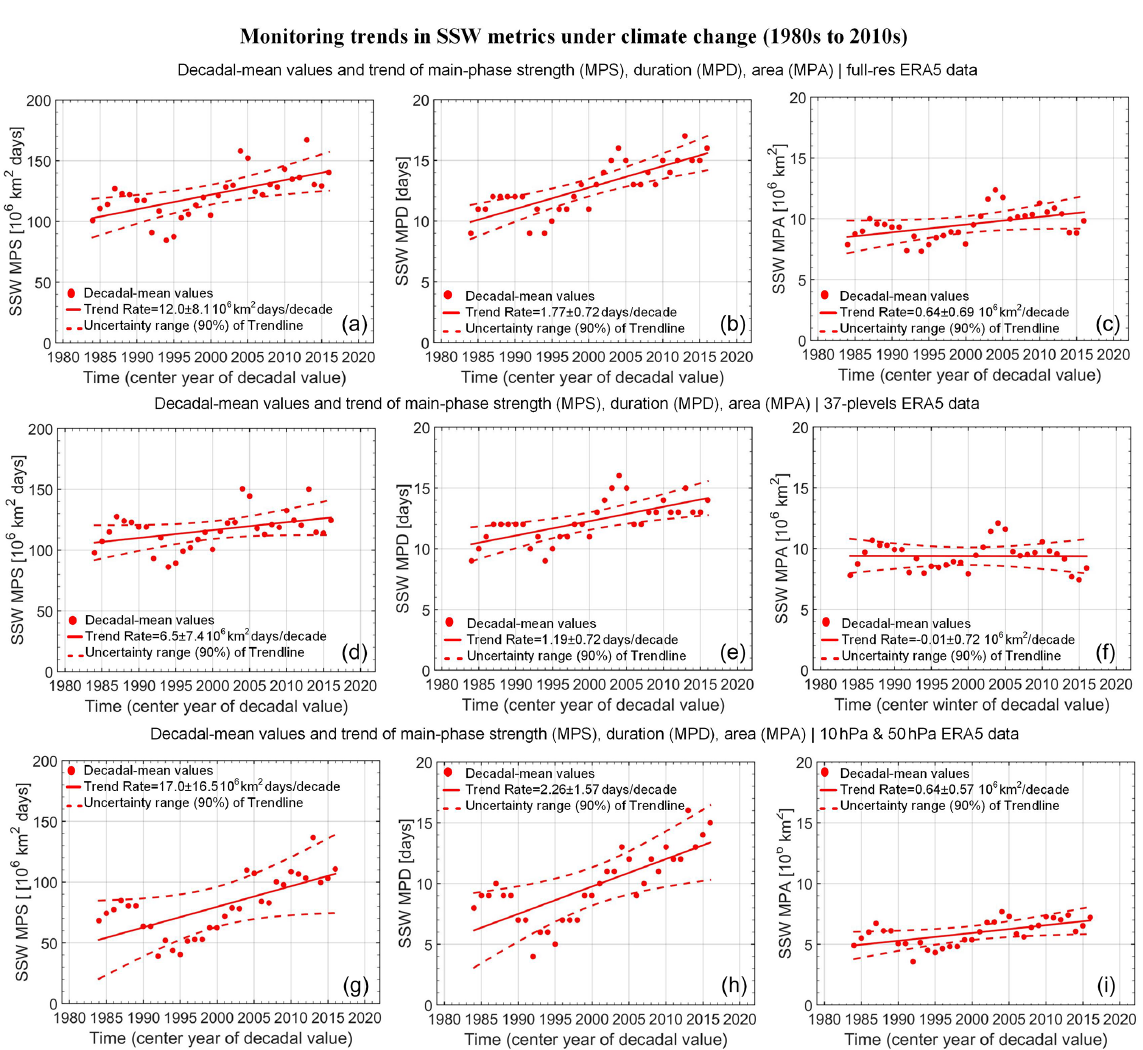
Figure 11. Monitoring and assessment of long-term trends in the three core SSW metrics (main-phase strength, duration, and area) along the recent climate change period from the 1980s decade to the 2010s decade, noting also main statistical numbers within the respective panel legends. The results derive from the metrics as illustrated in Fig. 10 and are intercompared for the ERA5 temperature data input either taken in at full 137-model-levels resolution (“full-res ERA5 data”) (a–c) , coarser standard 37-pressure-levels resolution (“37-plevels ERA5 data”) (d–f) , or simple two-levels data extraction (“10hPa&50hPa ERA5 data”) (g–i) , respectively. For a description, see Sect.